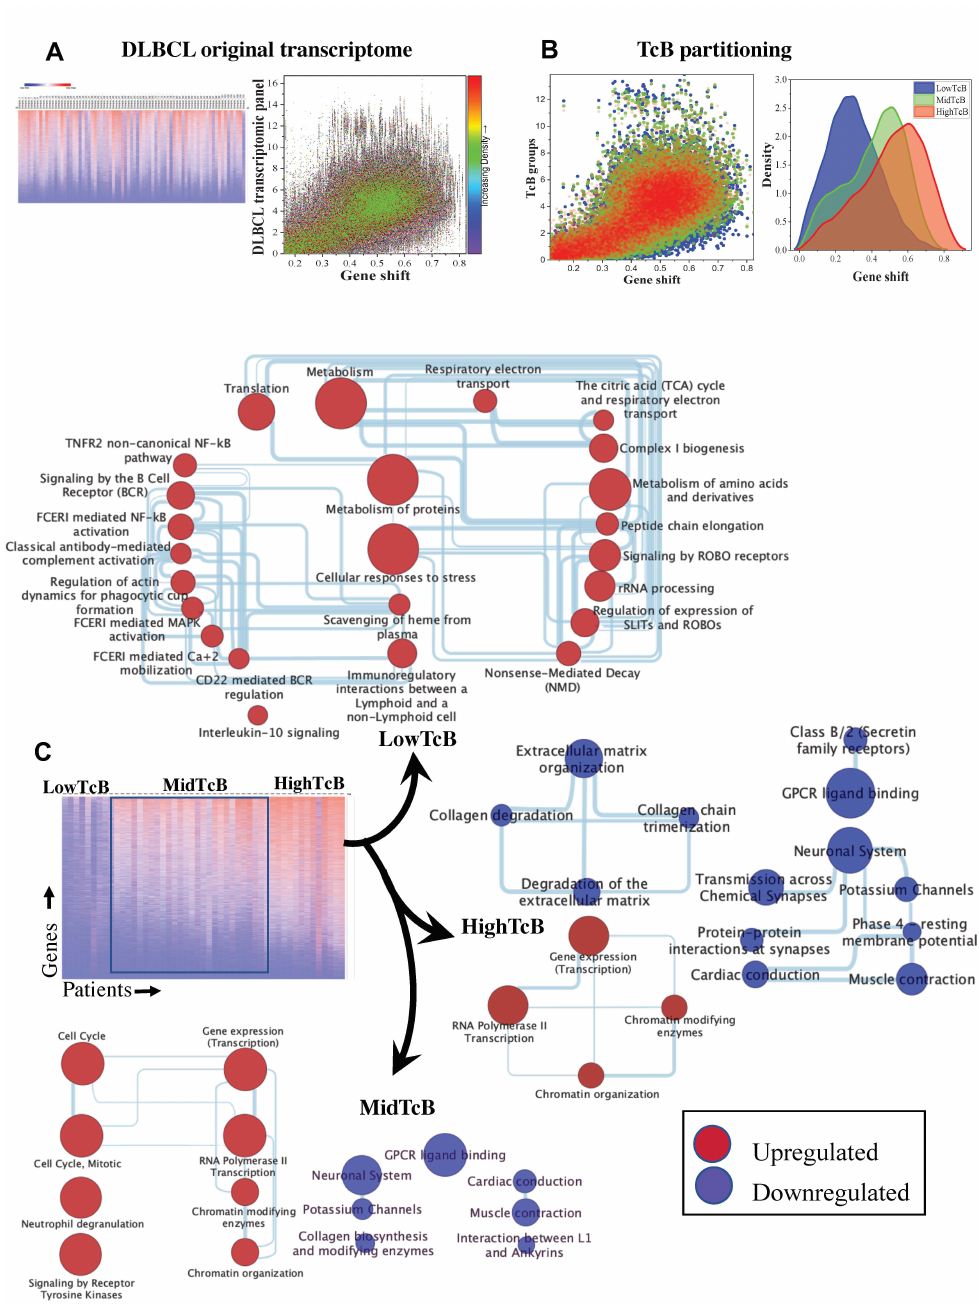
Figure 2. DLBCL transcriptome analysis for biological progression. ( A ) Heatmap of Cornell DLBCL gene expression original matrix (patients and transcripts) and scatter plot of TPM (transcript per